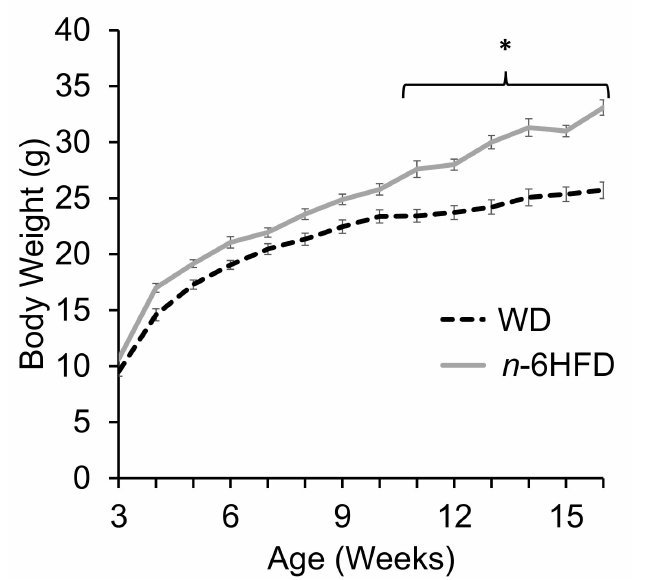
Figure 1. The n -6HFD induces higher body weight of male C57BL.J6 mice compared to the WD. Asterisks indicate statistical significance ( p < 0.05, n = 15).